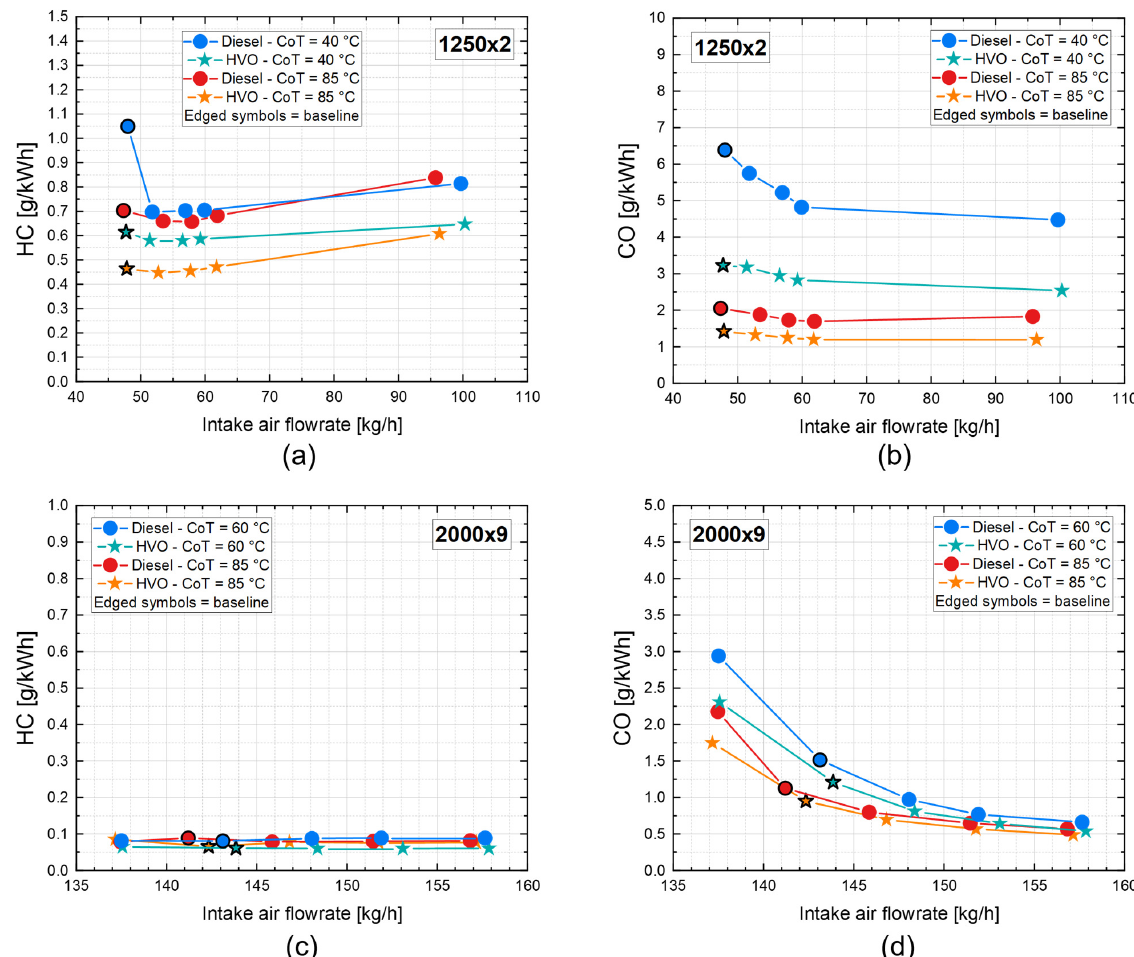
Figure 14. HC and CO emissions along intake air quantity sweep tests at 1250 × 2 ( a , b ) and 2000 × 9 ( c , d ). Comparison between diesel and HVO at high and low coolant temperatures. Warm colors represent high coolant temperatures, while cool colors represent low coolant temperatures. Circles represent diesel, while stars represent